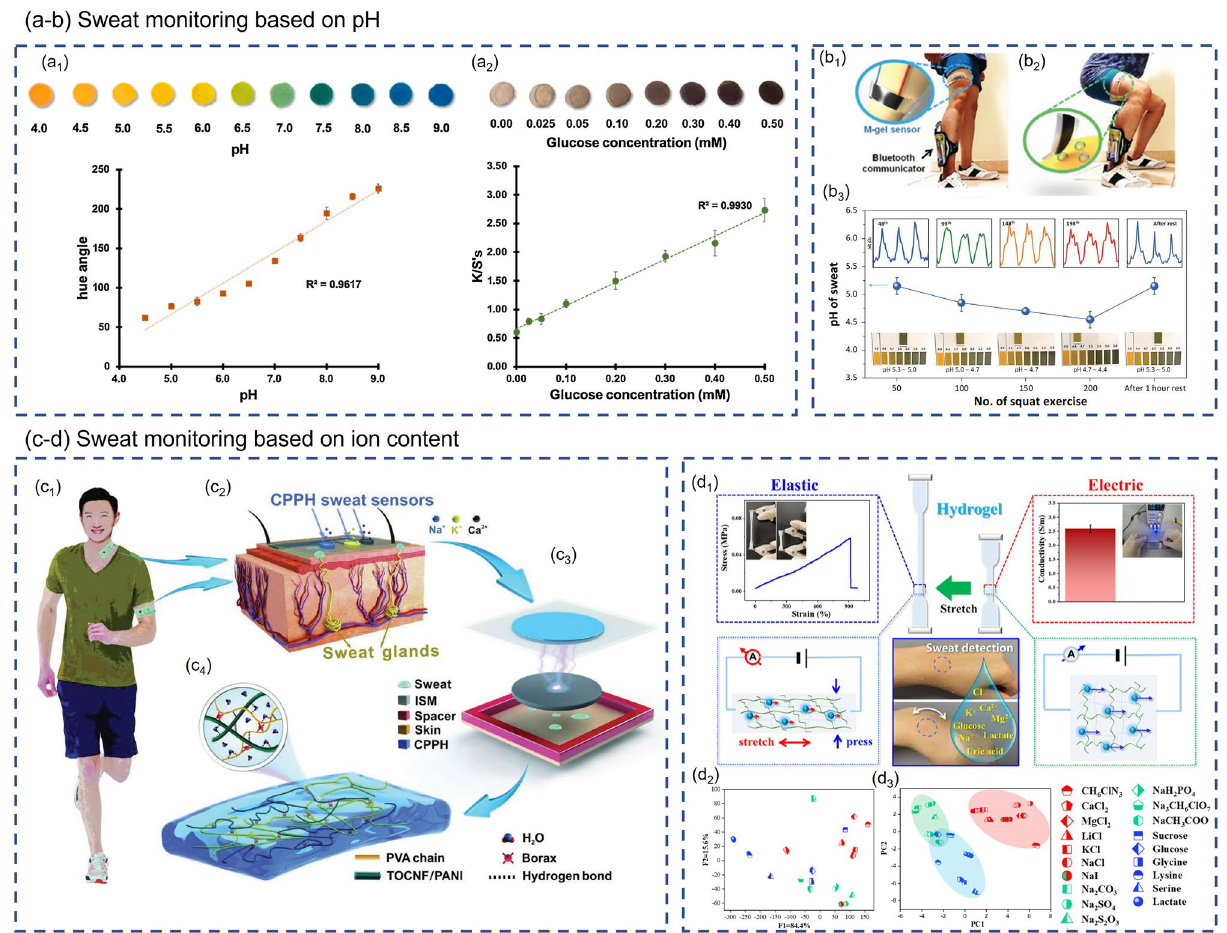
Fig. 7 Composite hydrogel-based wearable sweat monitoring. a , b Composite hydrogel-based pH sensors for wearable sweat monitoring [143, 148]. a 1 Standard color chart and a calibration plot of the BC/CMC-based pH sensor over a pH range of 4.0–9.0. a 2 Standard color chart and a calibration plot of BC/CMC-based glucose sensor in a concentration range of 0.00–0.50 mM glucose. Reproduced with permission. Copyright 2021, Elsevier. b 1 Before exercise, M-hydrogel sensor and bluetooth communicator were installed on the thigh and ankle, respectively. b 2 Sweat makes contact with M-hydrogel sensor during squat exercise. b 3 Comparison of pH values measured by M-hydrogel sensor and pH test